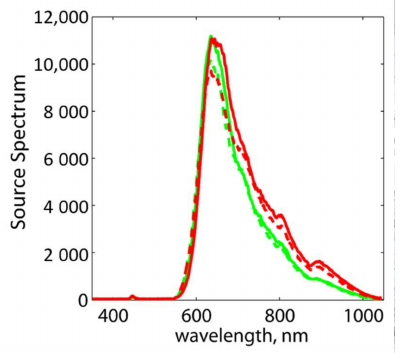
Figure 3. Substrate transmission at 30 ◦ incline, showing the stability of the source output spectra. These spectra are collected for each angle of incidence and used later for normalizing procedures. Green and red lines represent TM and TE polarizations, respectively. The dashed variants show the stability of each after one